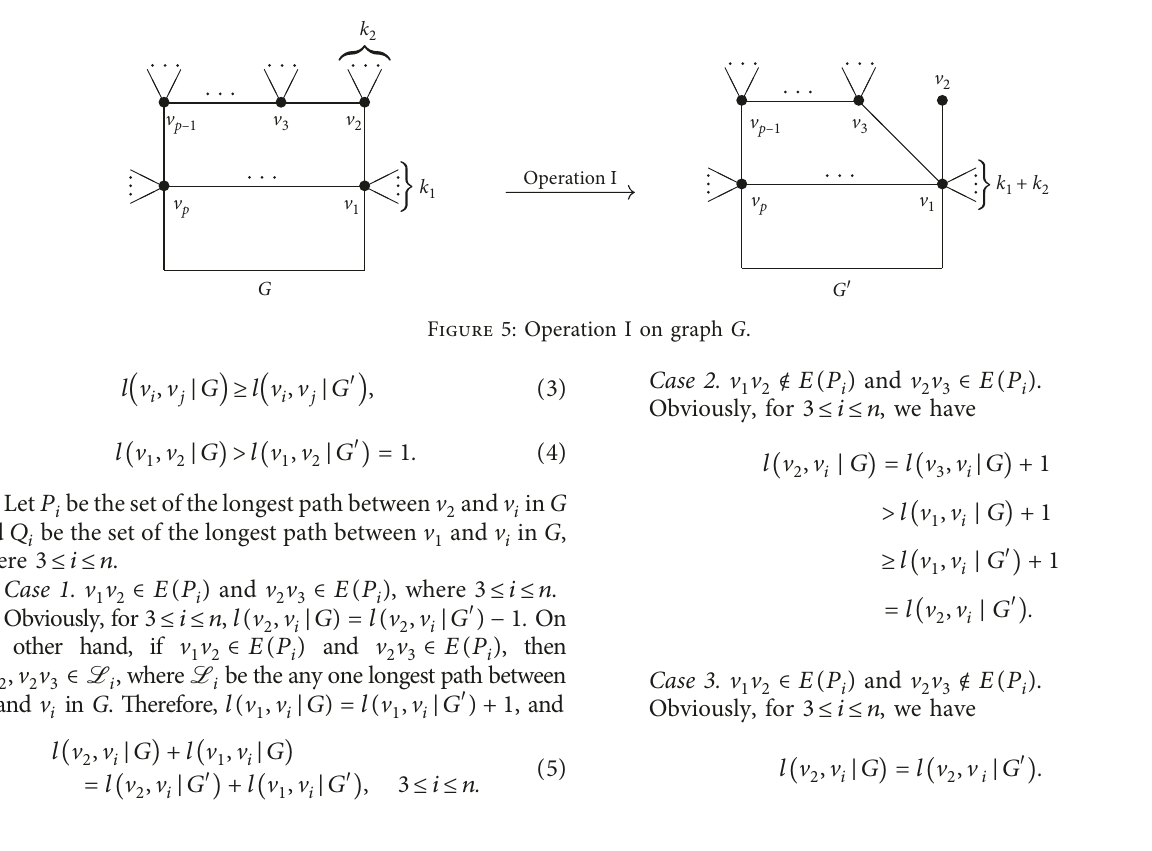
Figure 4: The cycle-lifting transformation.